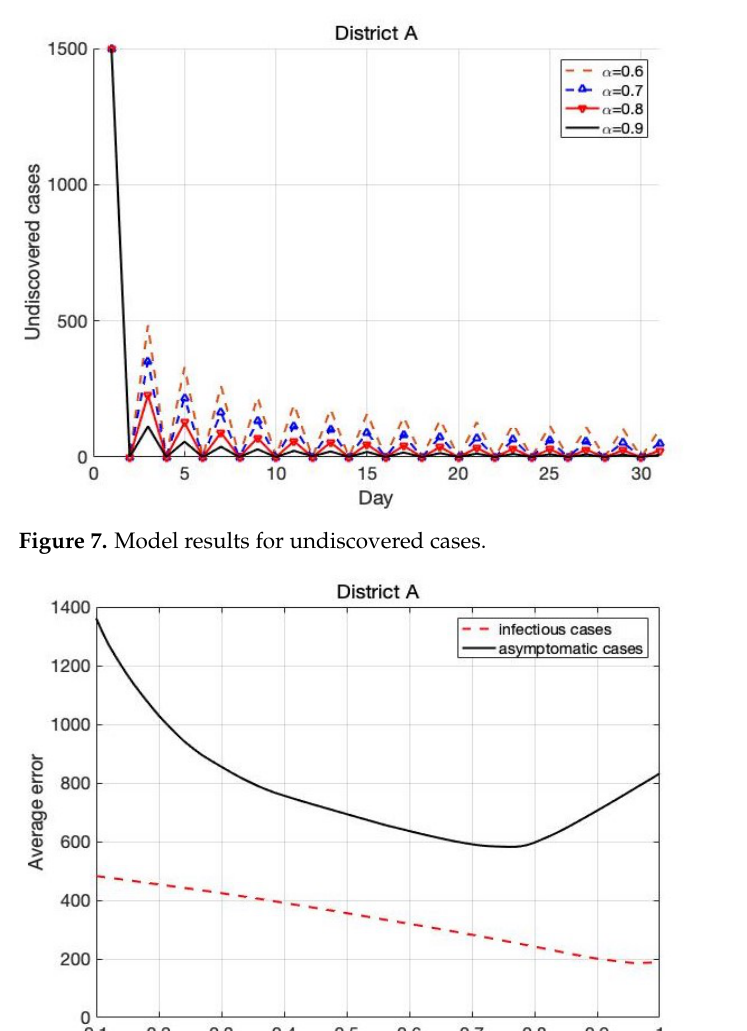
Figure 6. Model results for asymptomatic cases.